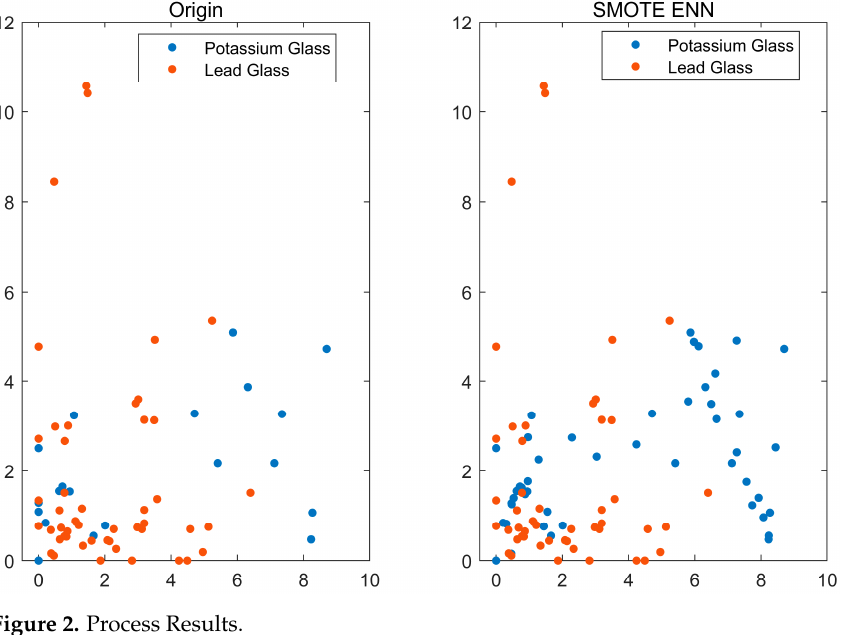
Figure 2. Process Figure 2. Process Results.